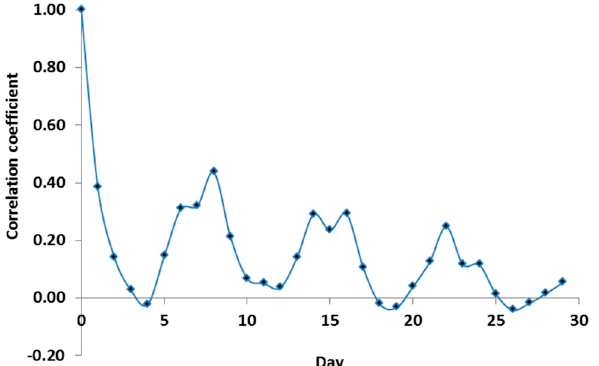
Figure 4. Correlation coefficient curve.